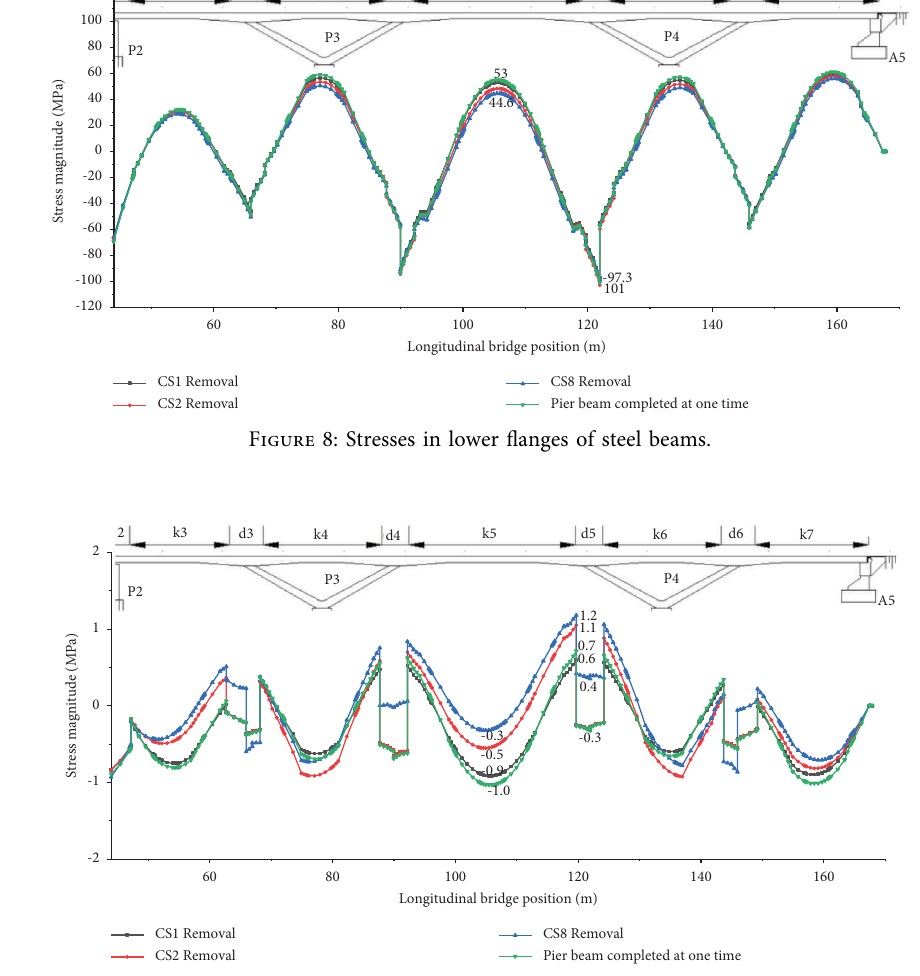
Figure 9: Stresses at the upper edges of the bridge deck